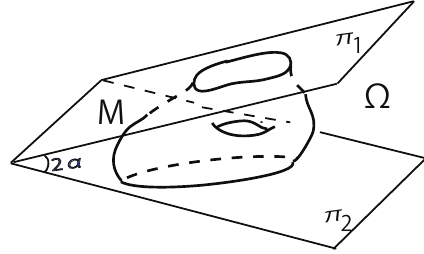
Figure 5. The wedge Ω and an admissible surface M